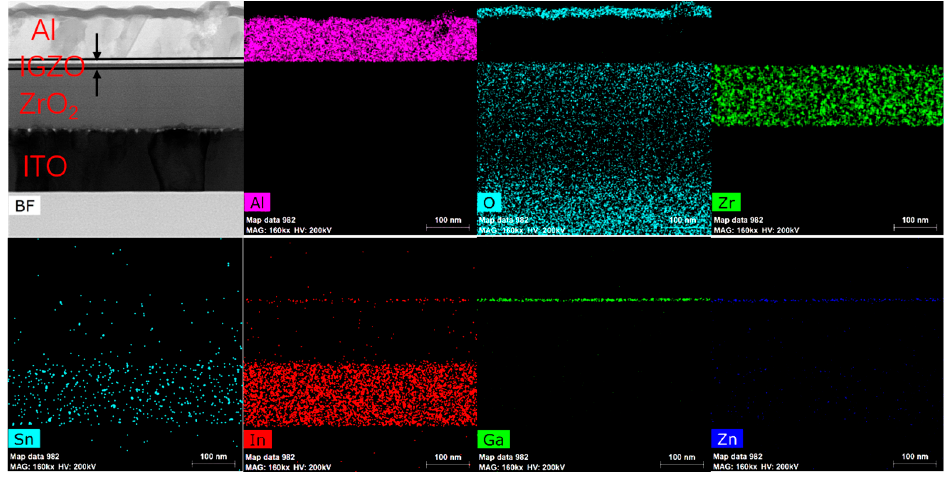
Figure 8. Energy dispersive X-ray spectrometer (EDS) of cross-sectional 0.6 M ZrO2-TFT.